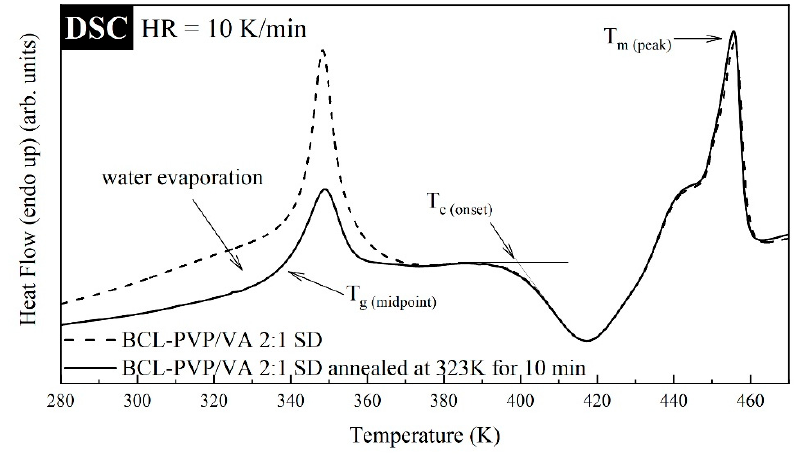
Figure 3. Exemplary differential scanning calorimetry (DSC) thermograms of the BCL-PVP/VA 2:1 spray-dried system before and after annealing.